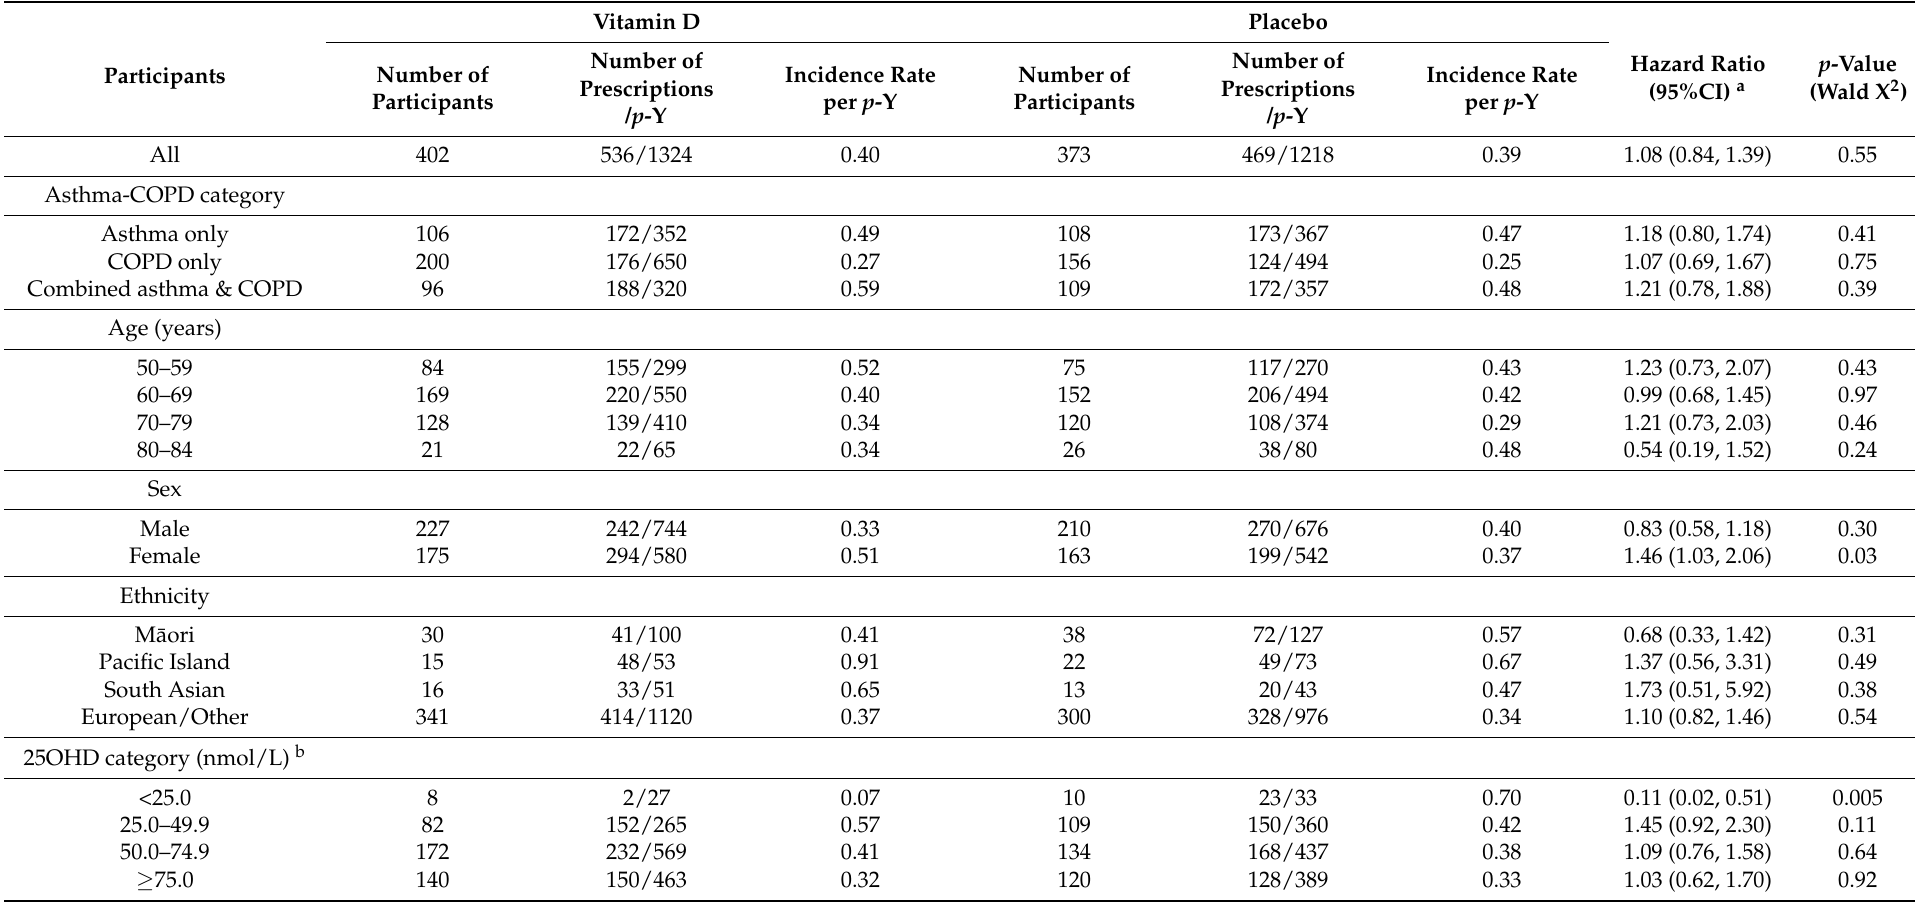
Table 2. Numbers, incidence rates, and adjusted hazard ratios of oral corticosteroid prescriptions (placebo as reference), by treatment